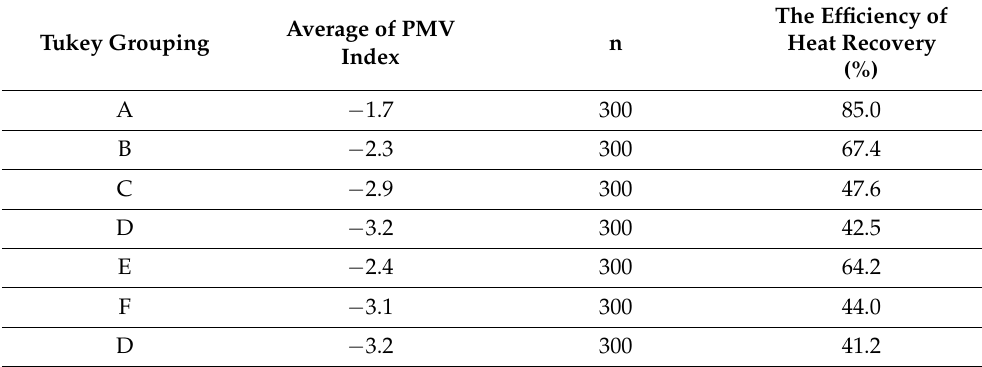
Table 7. The Tukey multiple comparison method tests for the PMV index characteristic in groups based on the efficiency of heat recovery factor levels. Supply/exhaust cycle: 10